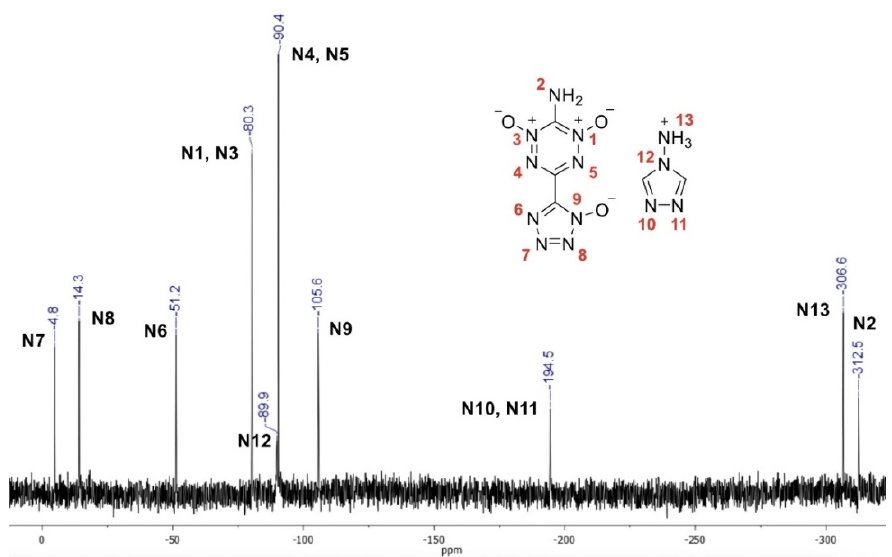
Figure 2. 15 N NMR spectra of aminotriazolium salt 12 .